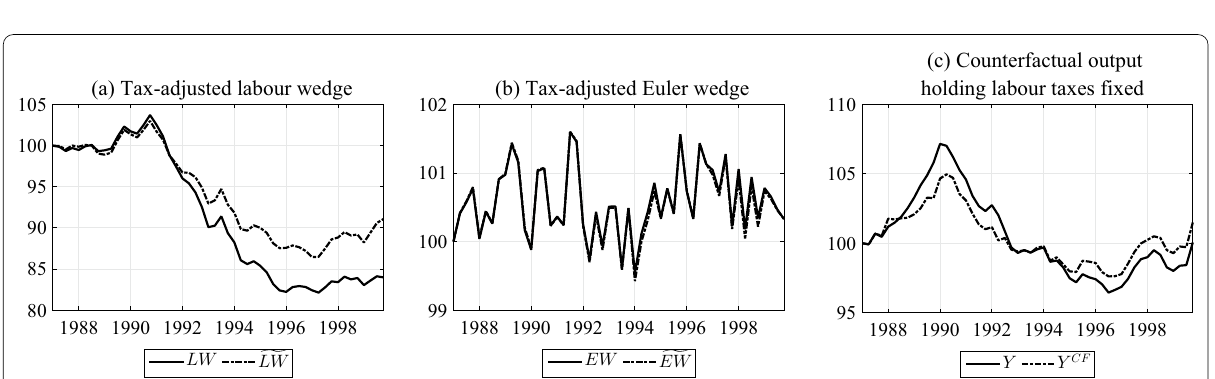
Fig. 17 Robustness: The role of taxes for ν = 2 (1987Q1–1999Q4). LW